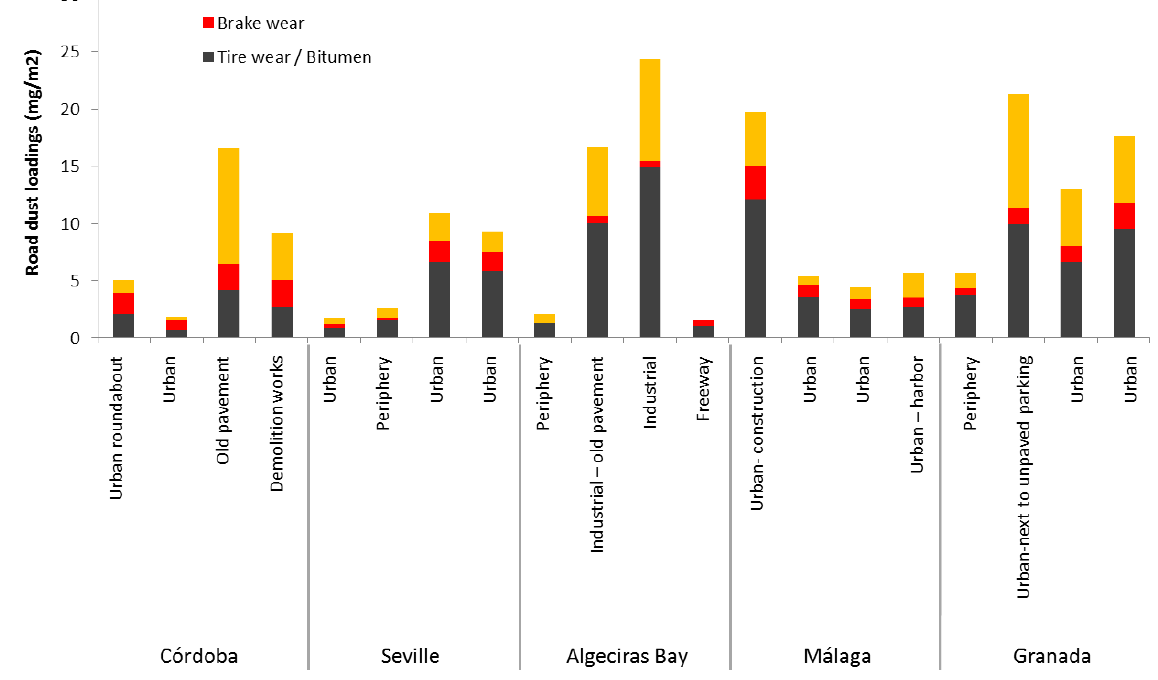
Fig. 3. Absolute contribution (mgm − 2 ) of road dust sources to road dust mass